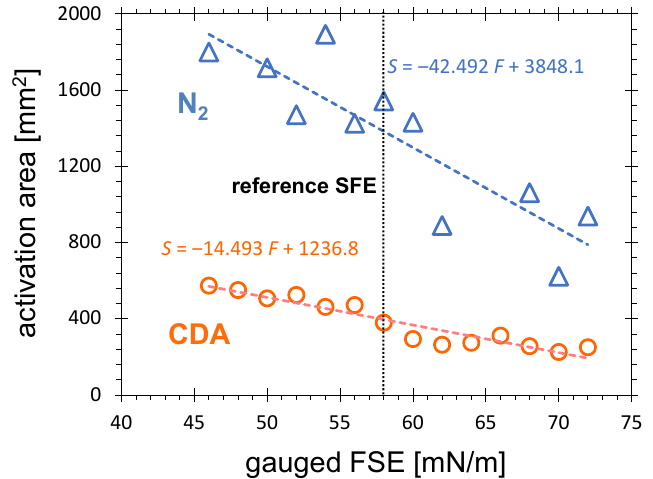
Figure 4. The activation area on HDPE substrates treated for 10 s by CDA or nitrogen PDD at a distance of 5.5 mm from the PCPD tip, gas flow of 8.0 SLM and visualized with test inks gauged with SFE from 46 to 72